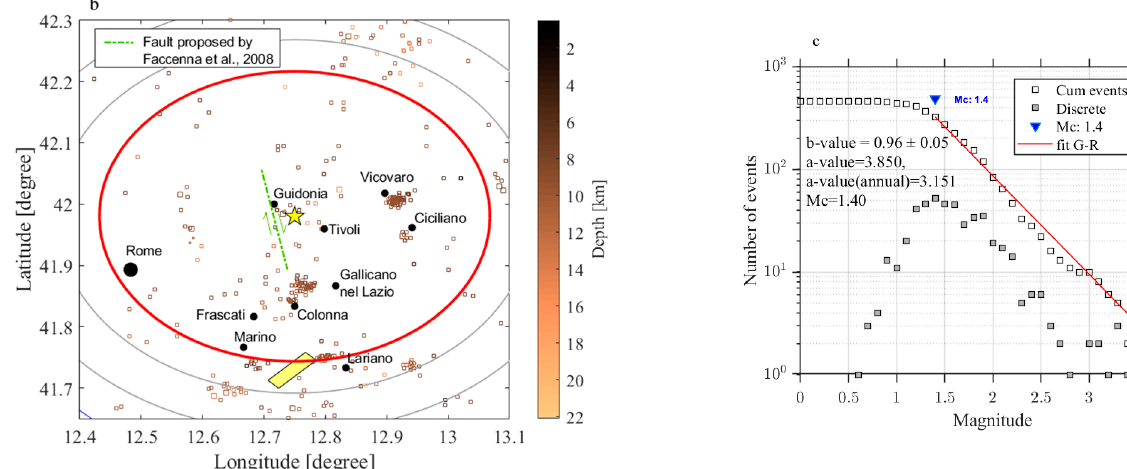
Figure 1. Earthquakes that occurred in Central Italy from 1st January 2018 until 1st January 2023. ( a ) Geographical map of the earthquake (EQ) events with active seismic fault from DISS: the yellow star represents the event of Guidonia 1 January 2023, ML = 3.3; the red circle is its Dobrovolsky area; grey circles are the tested Dobrovolsky areas; the green dashed rectangle is the area used to calculate atmospheric time series, and the black dashed circle is the research area for ionospheric investigations. The adapted colour bar scale shows the hypocentral depth. ( b ) Enlargement of the map around the Guidonia (Rome) earthquake. In addition to previous details, the principal local towns are shown in relation to recorded seismicity. The transcurrent fault proposed by Faccenna [1] is reported with a dashed-dot green line. ( c ) The Gutenberg–Richter (G–R) distribution of the magnitude of the earthquakes, excluding the seismicity in the northeast corner of the map, i.e., within a radius of 50 km from Guidonia epicentres. The magnitude of completeness and G–R parameters are reported.